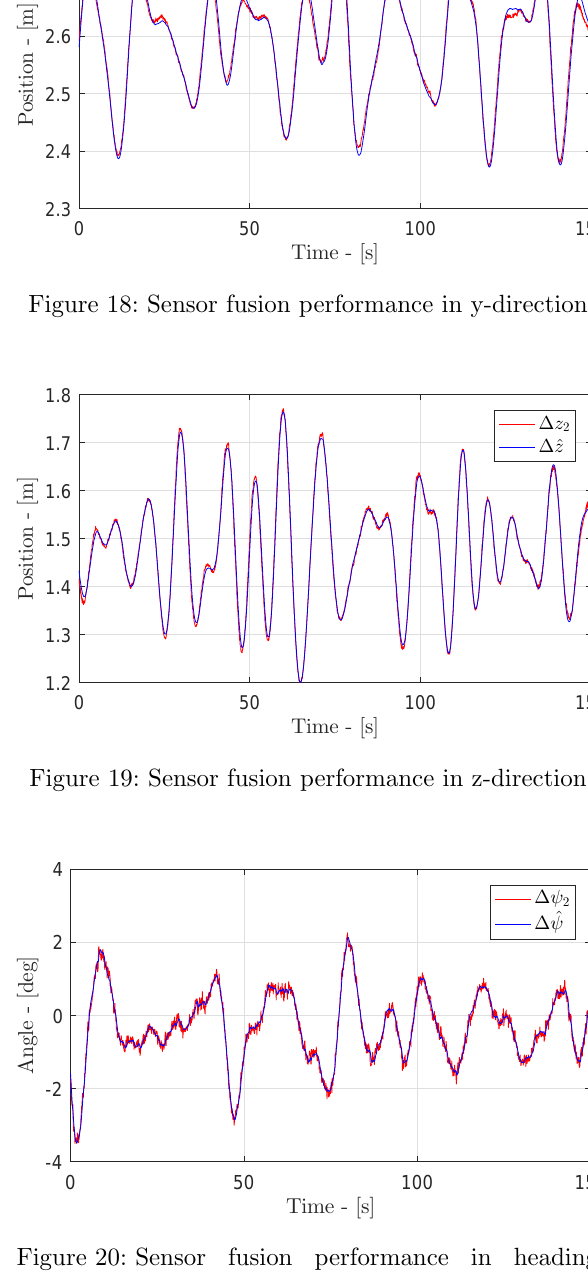
Figure 20: Sensor fusion performance in heading-